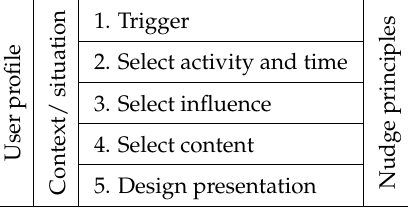
Figure 2. Steps in a nudge design